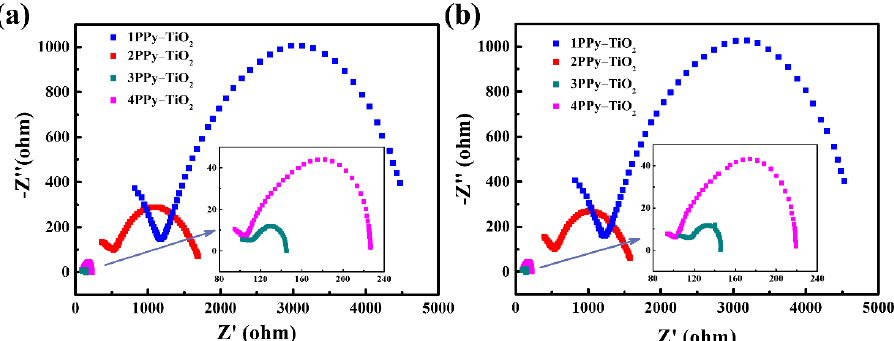
Figure 7. Nyquist plots of FTO-nPPy-TiO 2 -FTO devices prepared by different deposition times with 254 nm ( a ) and 365 nm ( b ) UV light illumination. 254 nm ( a ) and 365 nm ( b ) UV light illumination.